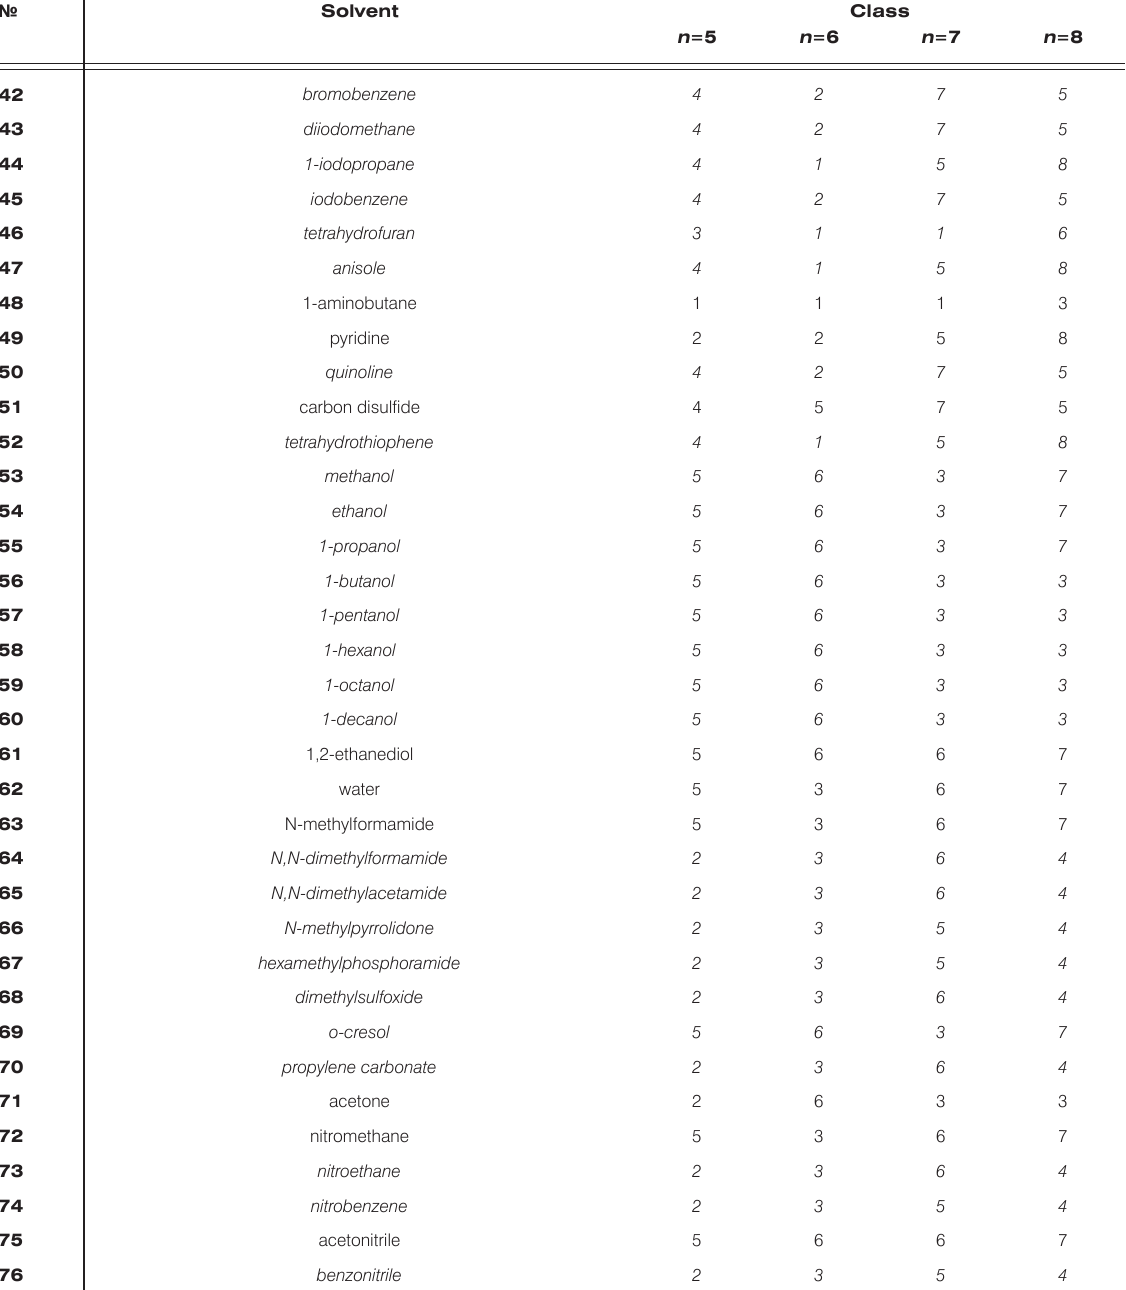
Group III consists of only cis-decalin, carbon disulfide, and tetrachloroethylene. Cis-decalin has a higher surface tension than cyclic hydrocarbons. Two polyhalogen- substituted aliphatic hydrocarbons (tetrachloromethane and tetrachloroethylene) were assigned to different groups due to their surface tension